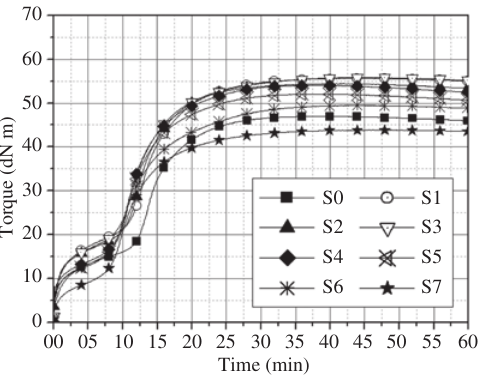
Figure 1 Cure curves of the investigated rubber compounds taken at 150 ° C.